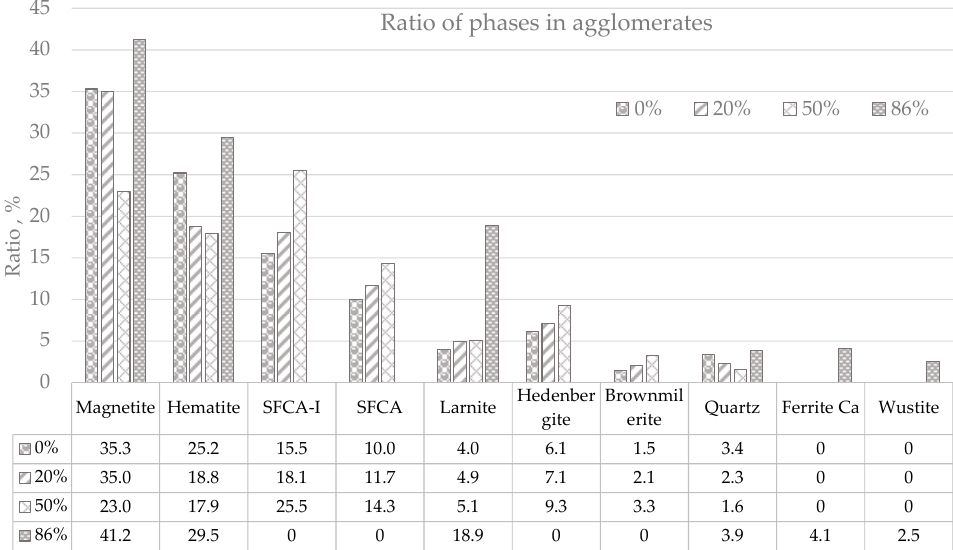
Figure 3. Effect of fuel substitution on mineralogical composition of agglomerates. Figure 3. E ff ect of fuel substitution on mineralogical composition of